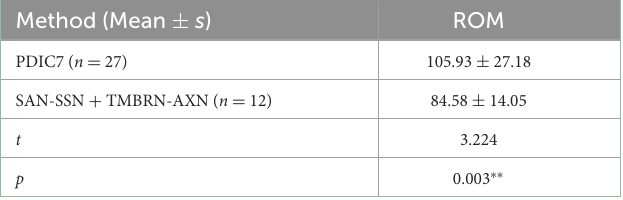
TABLE 1 t -test result of the maximal range of shoulder abduction in two